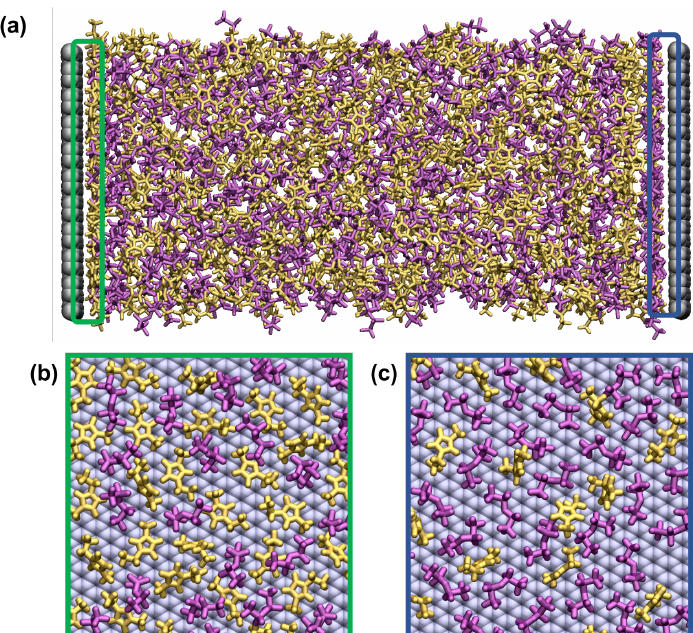
Figure 3. ( a ) A snapshot of [C 2 mim][NTf 2 ] system taken after 10 ns of a constant potential simulation with ∆Ψ = 4. A view of the ions that have any atom within 4 Å of of the electrodes for the same system with ( b ) negative electrode and ( c ) positive electrode. Colour scheme: yellow, pink and grey for [C 2 mim] + ions, [NTf 2 ] − ions and graphene electrode. In ( a ), the regions shown in ( b , c ) are marked with green and blue rectangles,